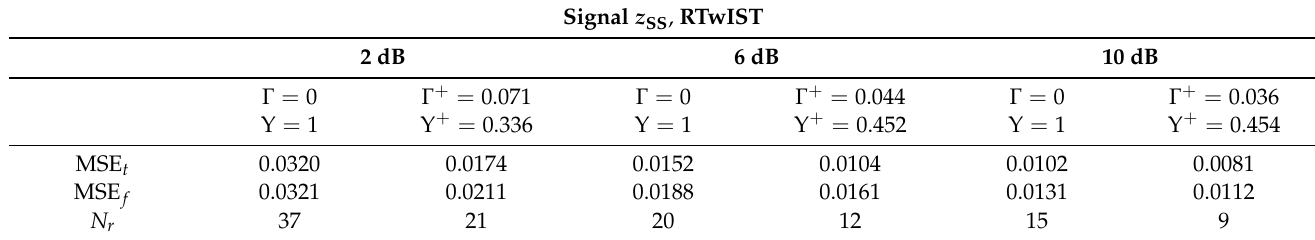
Table 4. Performance comparison of the RTwIST algorithm with the full N (cid:48) τ × N (cid:48) ν area ( ( Γ , Υ ) = ( 0,1 ) ) versus the proposed CS-AF area selection ( Γ + , Υ + ) for the z SS embedded in noise with different SNRs. Signal z SS , RTwIST 2 dB 6 dB 10